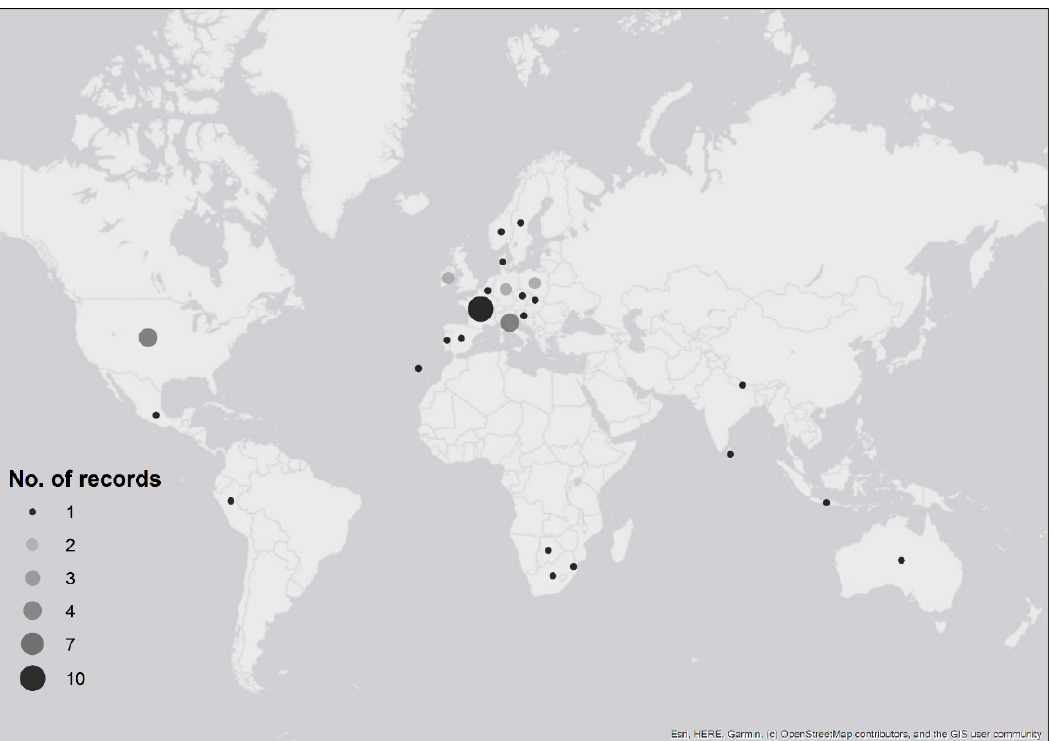
Figure 2. Map showing recent travel history of people submitting confirmed and possible imported tick records to Public Health England’s Tick Surveillance Scheme between January 2006 and December 2018. The numbers of records received from each country are indicated by the size of the circle. Two records are not shown: one record that was acquired in either Holland, Germany or France; another record that was acquired in either the Canadian Rockies or north-western USA (see Table 1). Maps have been reproduced with permission from Ordnance Survey on behalf of Her Majesty’s